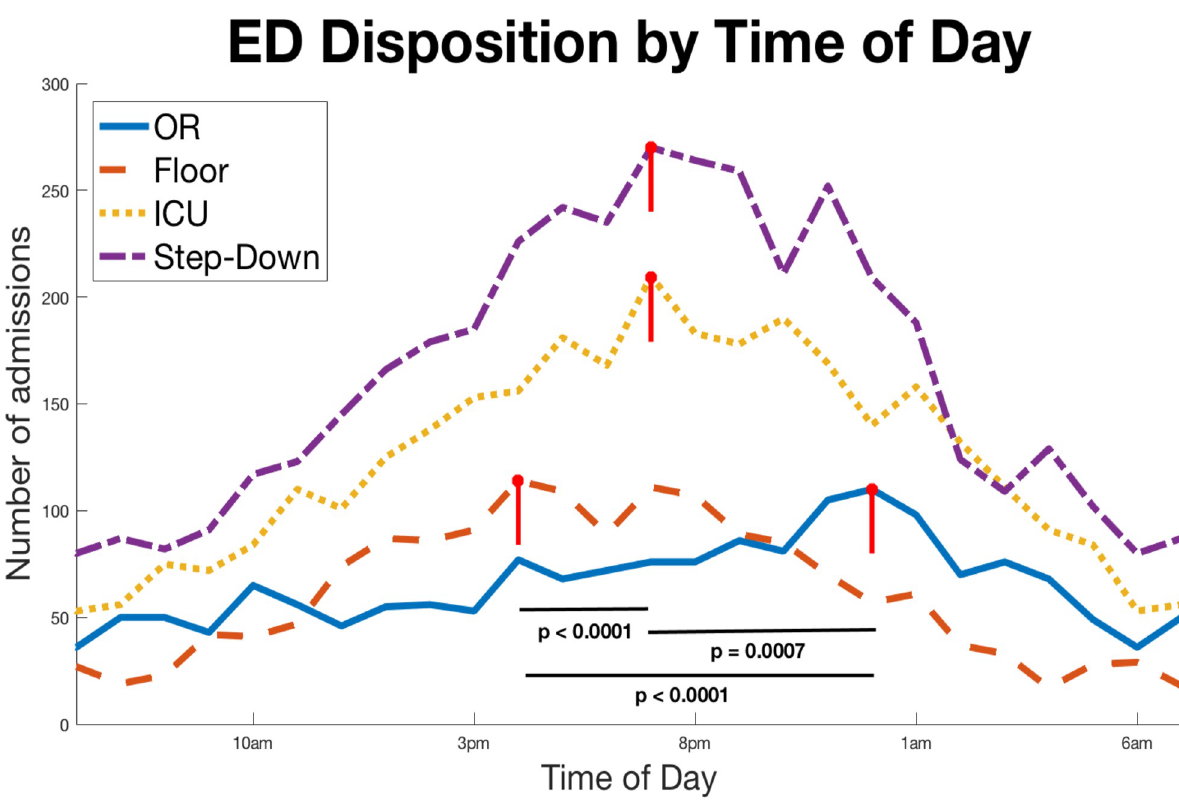
Fig 2. Absolute frequency of trauma patients sent from the emergency department to each of these disposition by time of day. Patients admitted to the floor peak earliest (red-dashed). Step-down (purple-dashed) and ICU (yellow-dashed) peak next during the day, and operative patients present